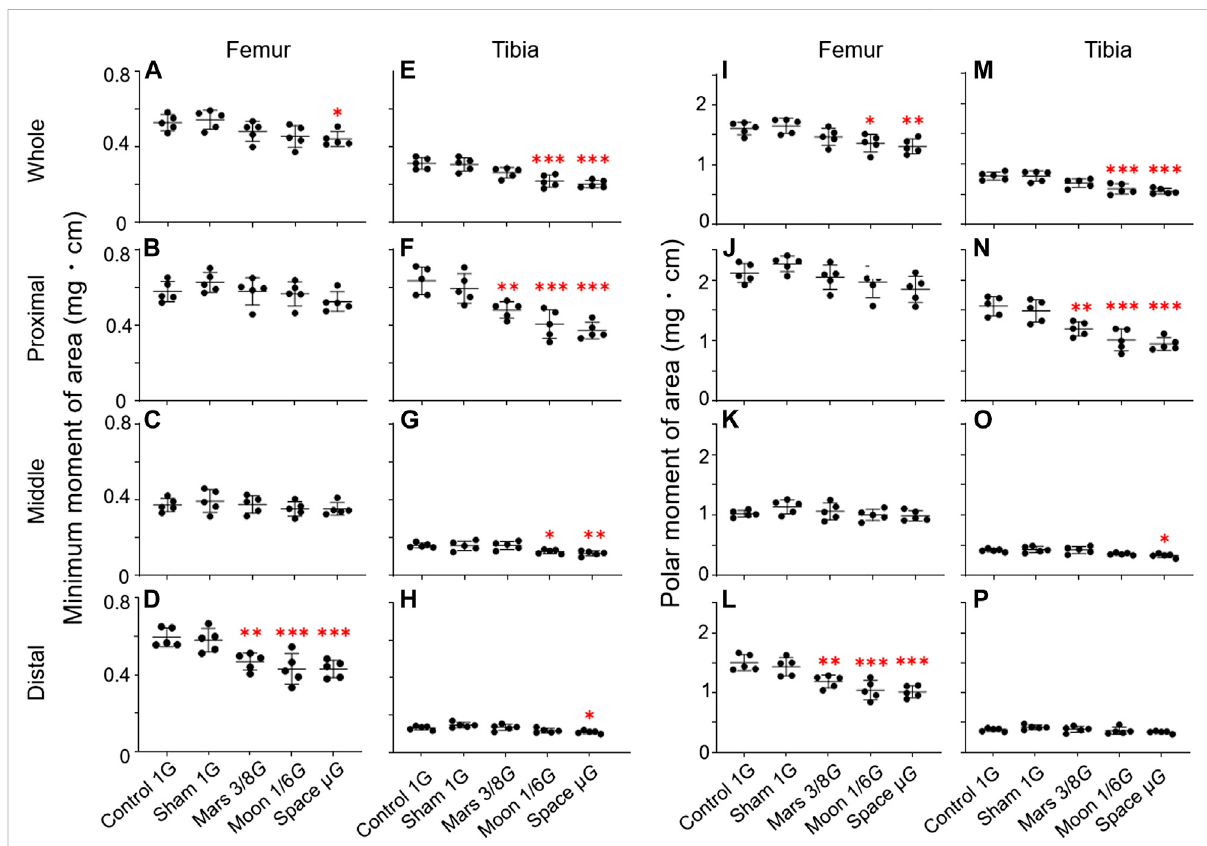
FIGURE 7 Mechanical indexes of the femur and tibia [minimum moment of inertia of area (MMA) and polar moment of inertia of area (PMA)] compared among the fi ve experimental groups. (A – D) Femoral MMA, (E – H) tibial MMA, (I – L) femoral PMA, and (M – P) tibial PMA. (A,E,I,M) Whole femur/tibia, (B,F,J,N) proximal femur/tibia, (C,G,K,O) middle femur/tibia, and (D,H,L,P) distal femur/tibia (Mean ± SD, n = 5. *p < 0.05 vs. control group, **p < 0.01 vs. control group, ***p < 0.001 vs. control group, one-way analysis of